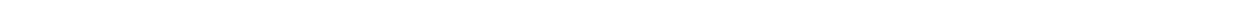
Fig. 5 TDP-43 oligomerization is essential for its role in RNA metabolism. a Schematic overview of rescue experiment to assess the role of TDP-43 oligomerization in RNA splicing. Point mutations interfering with TDP-43 oligomerization are schematically marked by red asterisks below the NTD. b Immunoblot (from 12% denaturing polyacrylamide gel) using an antibody against mouse/human TDP-43, showing speci fi c downregulation of endogenous mouse TDP-43 and overexpression of RNAi resistant GFP-tagged wild type and oligomerization mutant human TDP-43 (GFP-TDP-43-4M/5M/6 M) in mouse NSC-34 cells ( upper panel ). Actin is used as protein loading control ( lower panel ). Immunoblots are representative of four independent experiments. c Semi-quantitative RT-PCR analysis of selected target ’ s alternative splicing regulated by TDP-43. Left panel depicts alternatively spliced exons ( orange ) or cryptic exons ( red ) fl anked by their constitutive exons in blue boxes . Middle panel shows representative polyacrylamide gel images of semi-quantitative RT-PCR products for all conditions. Right panel shows quanti fi cation of splicing changes plotted as the ratio of exon inclusion/exclusion (on y -axis) against different conditions (on x -axis) averaged from four biological replicates and normalized to the ratio obtained for not treated (NT) cells that is arbitrarily set to 1. In all cases, the expression of wild-type TDP-43 ( green bars ) rescues the changes in splicing caused by downregulation of endogenous mouse TDP-43 (TDP-43 si-RNA, black bars ). The effect of each oligomerization mutant TDP-43 is shown ( red bars ). Statistical comparison of the inclusion/exclusion ratio between wild type and oligomerization mutants (4 M, 5 M, or 6 M) is indicated by asterisks above respective bars (* p < 0.05, ** p < 0.01, *** p < 0.001, two- tailed Student t -test). Standard deviation is represented by error bars. Full gels with molecular weight markers are shown in Supplementary Fig.